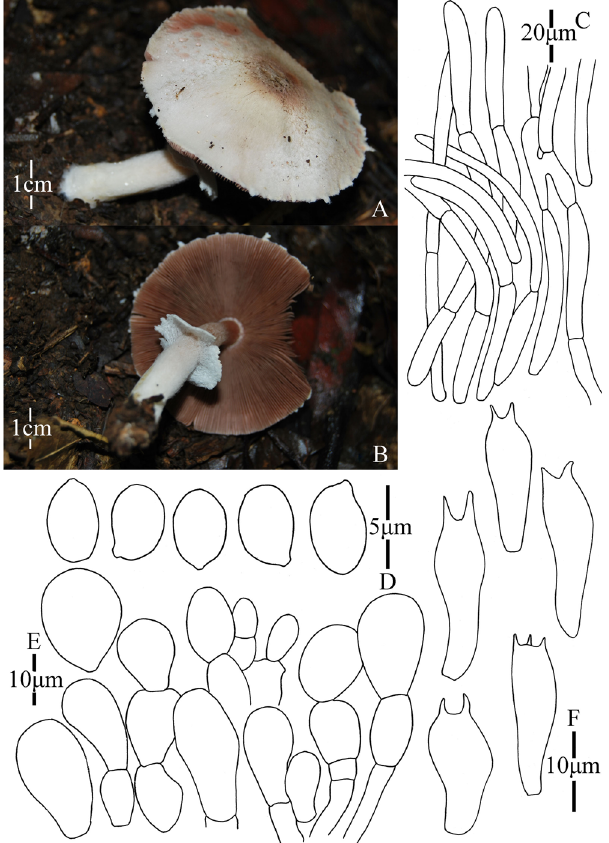
Figure 9. Morphology of Agaricus catenatus ( ZRL2012104 , holotype), ( A , B ): Basidiome in field ( ZRL2012104 ), ( C ): Pileipellis hyphae, ( D ): Basidiospores, ( E ): Cheilocystidia, and ( F ):